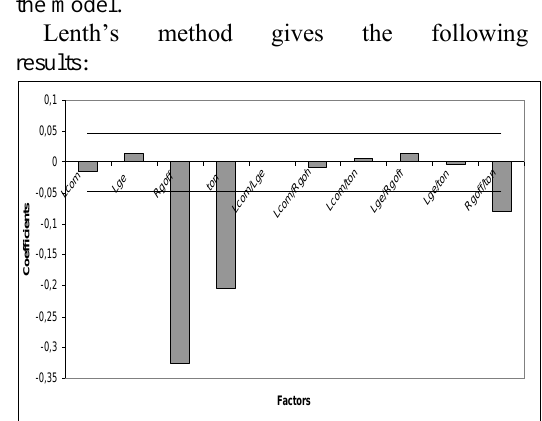
Fig. 3. Lenth’s method applied on dV/dt Straight lines are critical limits defined by Lenth in [19]. Only coefficients out of the area determined by these lines are really significant. So in this study, R , ton and the first order goff interaction R /t are significant. goff on All analyses gives the same results, only R , goff ton and the first order interaction R /t are really goff on significant on commutation speed